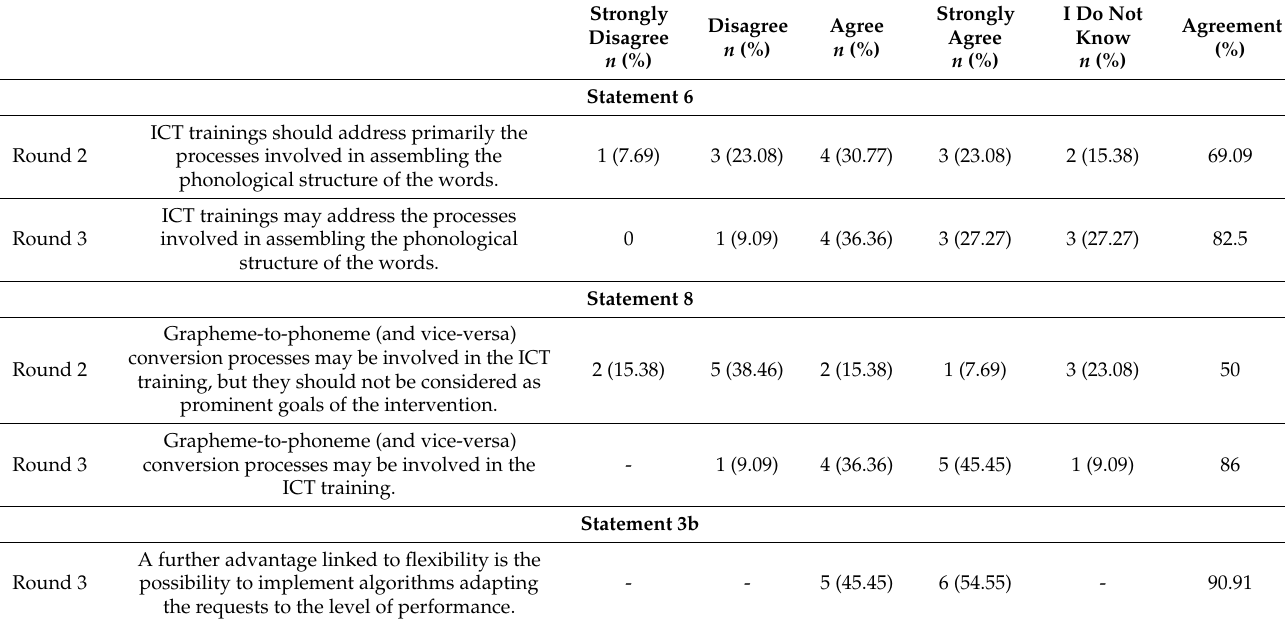
Table 3. Agreement ratings for the three statements added in Round 3 and the different ratings collected at Round 2 and Round 3. Number of responses and percentages (in parentheses) are reported for each choice.